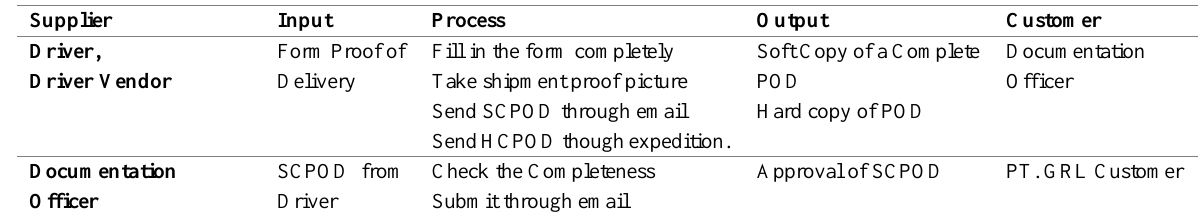
Table 2: SIPOC Diagram